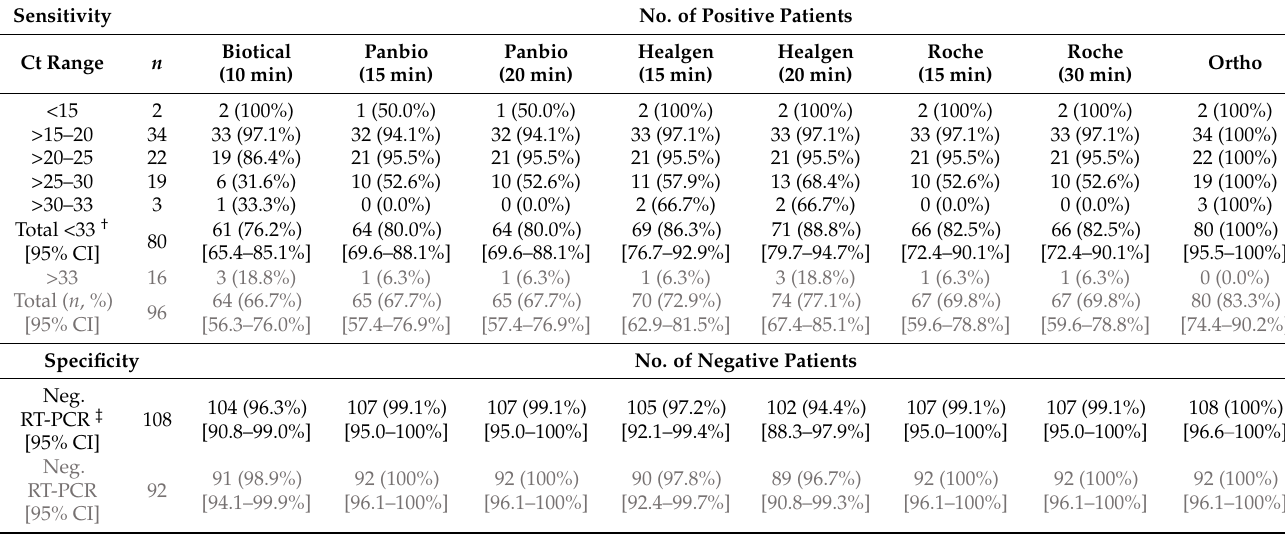
Table 2. Sensitivity and specificity of RAD and automated antigen tests across different ranges of RT-PCR Ct values. Results in grey provide results of all RT-PCR values, including those with a Ct value >33 (min–max range: 12.6–38.2) for sensitivity and specificity.